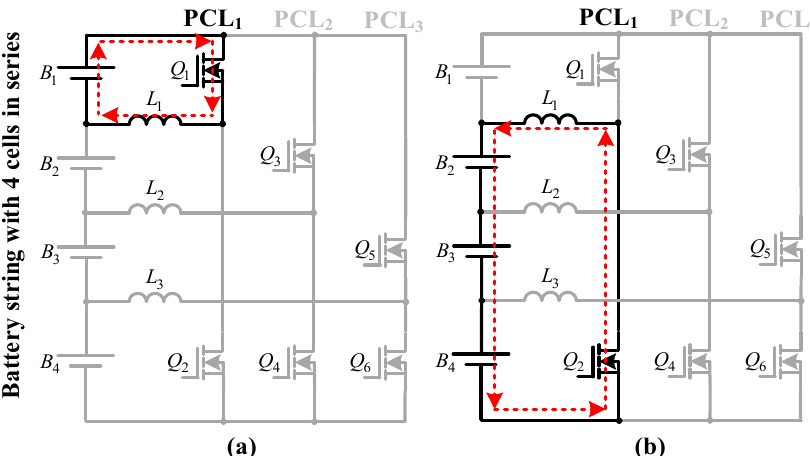
Figure 3. Operation of cell-to-sub-pack (C2SP) mode: ( a ) equivalent circuit (EC) of subinterval 1, ( b ) EC of subinterval 2.